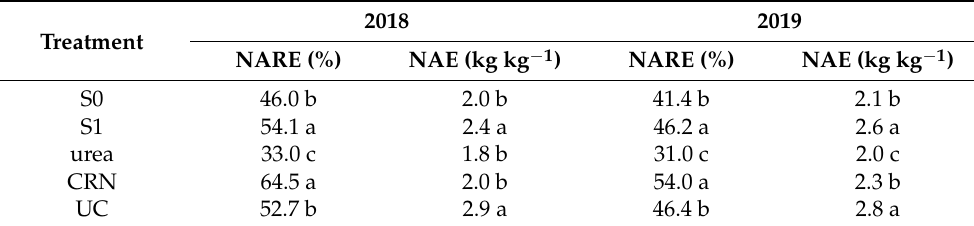
Effects of straw management and N-fertilization strategy on N-use efficiency in field-seeded cotton.